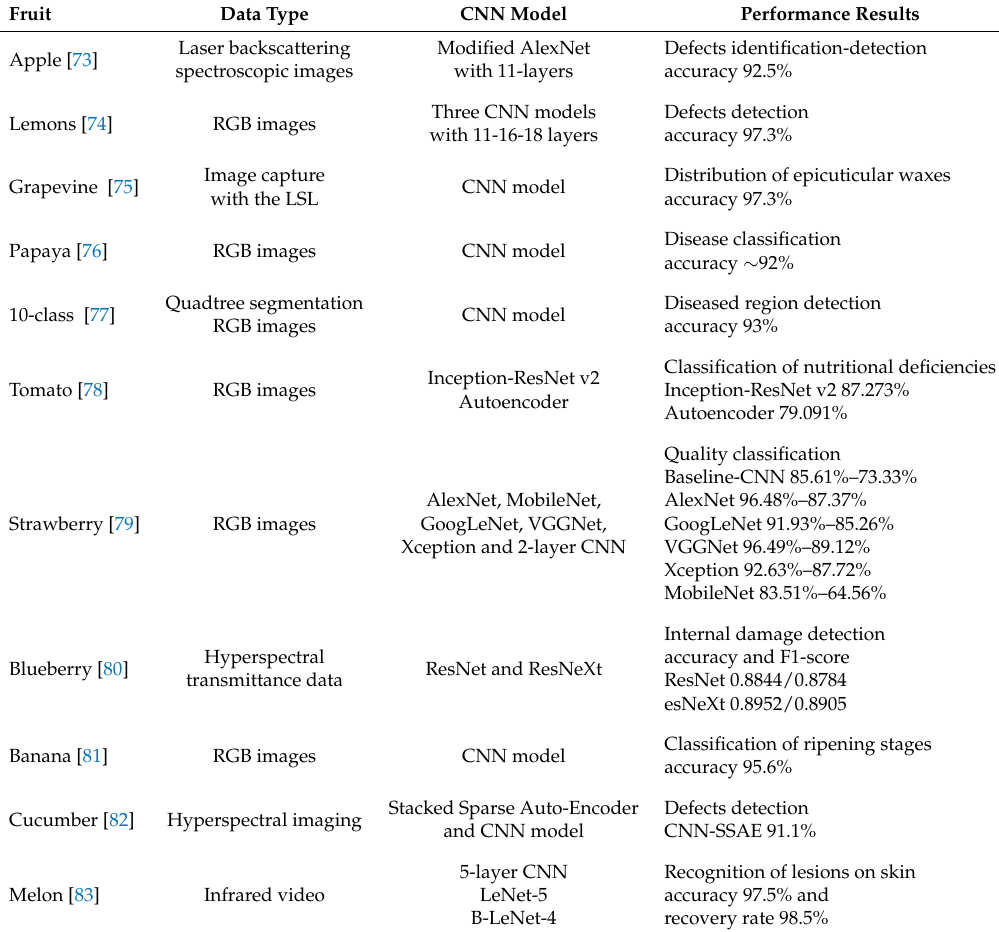
Table 2. Summary of state-of-the-art CNN-based approaches applied for fruit quality control tasks.